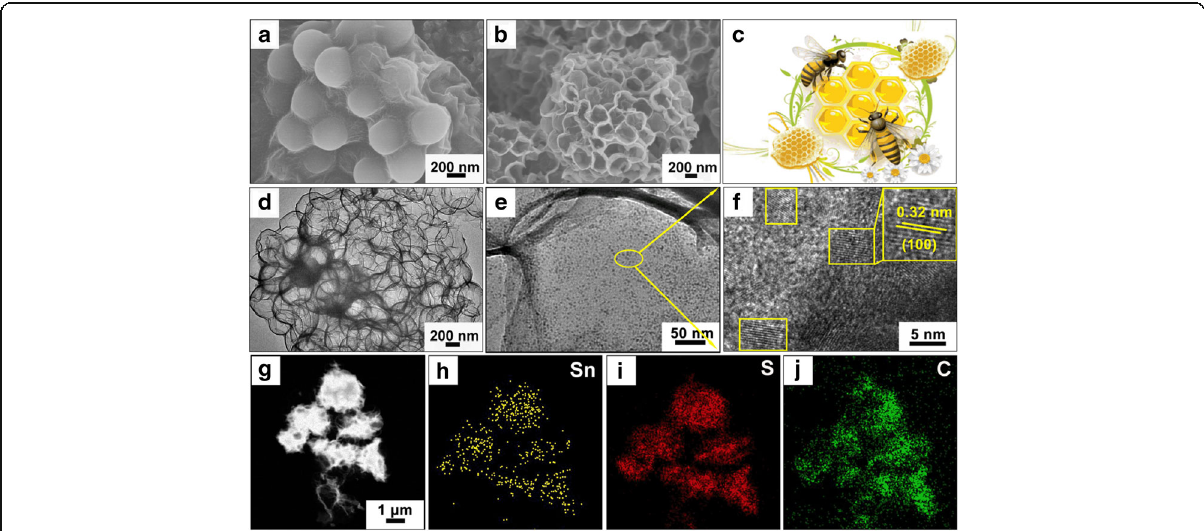
Fig. 1 a SEM image of the Sn salt-GO-PS composite. b SEM image of the 3D SnS 2 QDs/rGO composite. c Photograph of a honeycomb-like structure. d , e TEM images of the 3D SnS 2 QDs/rGO composite. f HRTEM image of the 3D SnS 2 QDs/rGO composite. g – j Elemental mapping images of Sn, S, and C elements